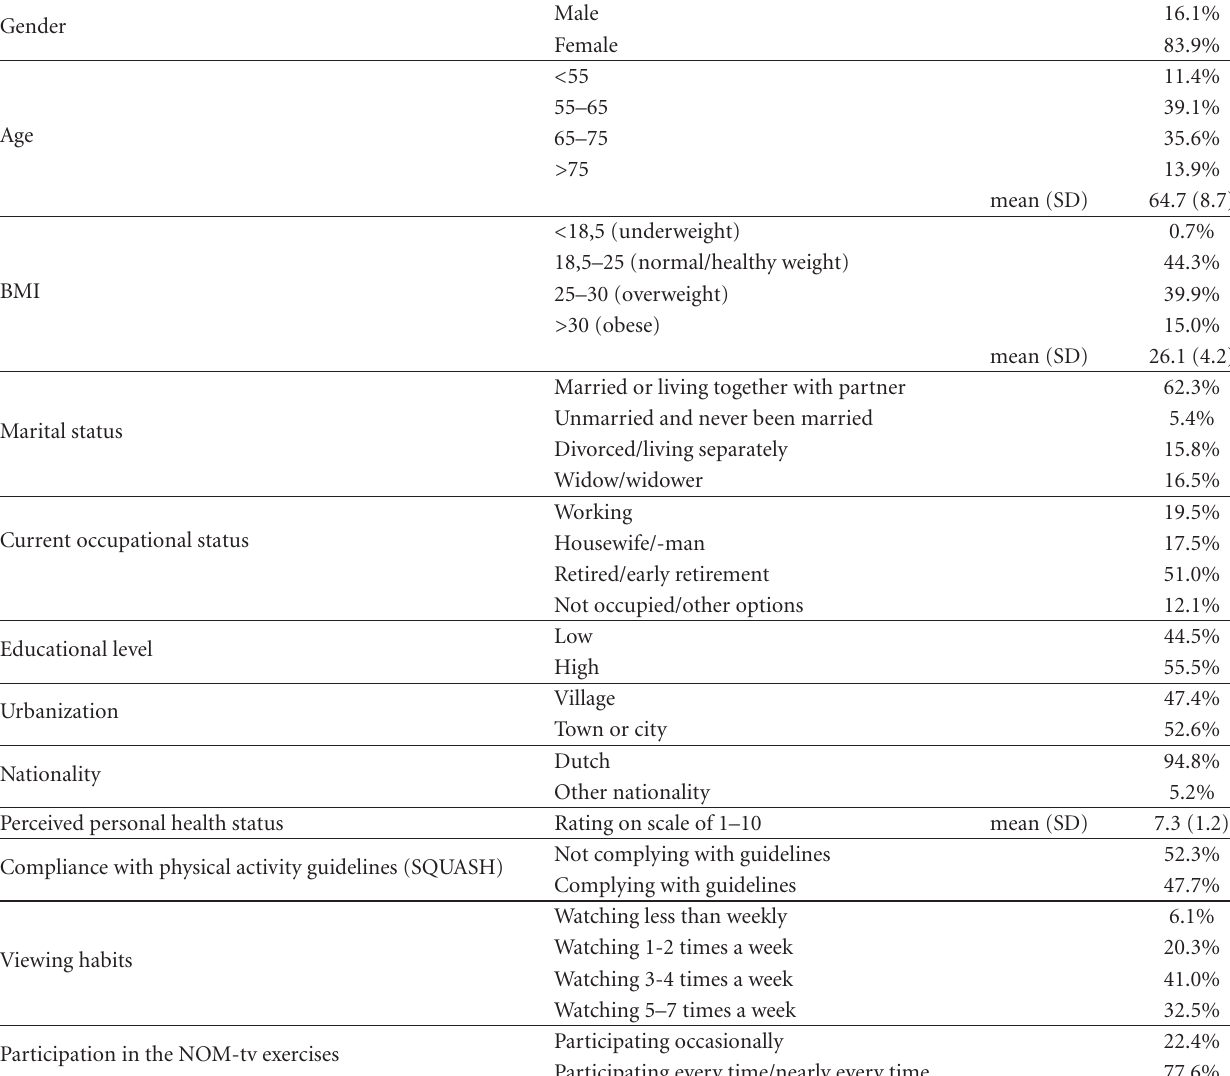
Table 1: Background characteristics of the respondents ( N =